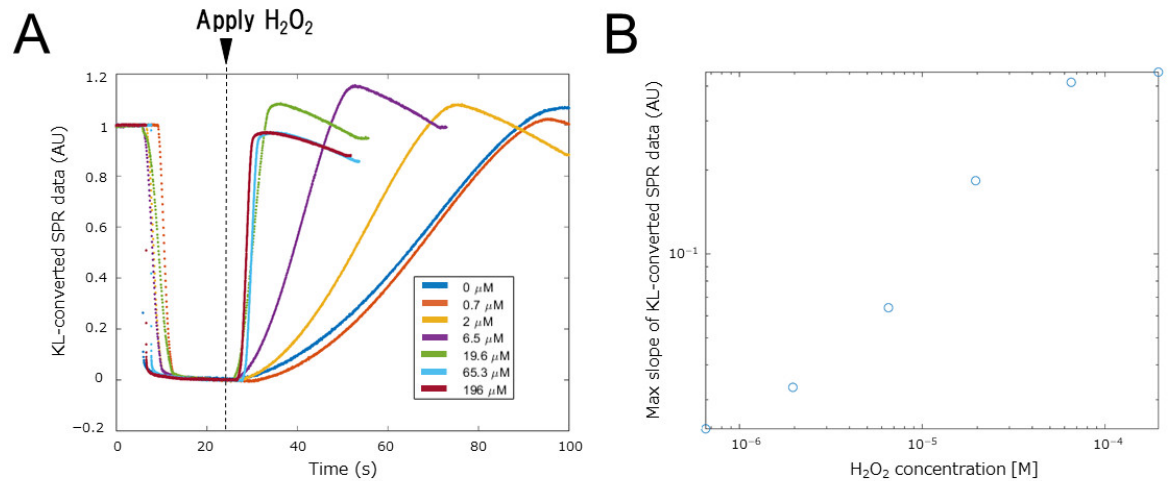
Figure 8. Variation in KL-converted SPR data with H 2 O 2 concentration. ( A ) Raw KL-converted SPR data showing transition with H 2 O 2 concentration. ( B ) Calibration curve for H 2 O 2 detection using the maximum slope of KL-converted SPR data.